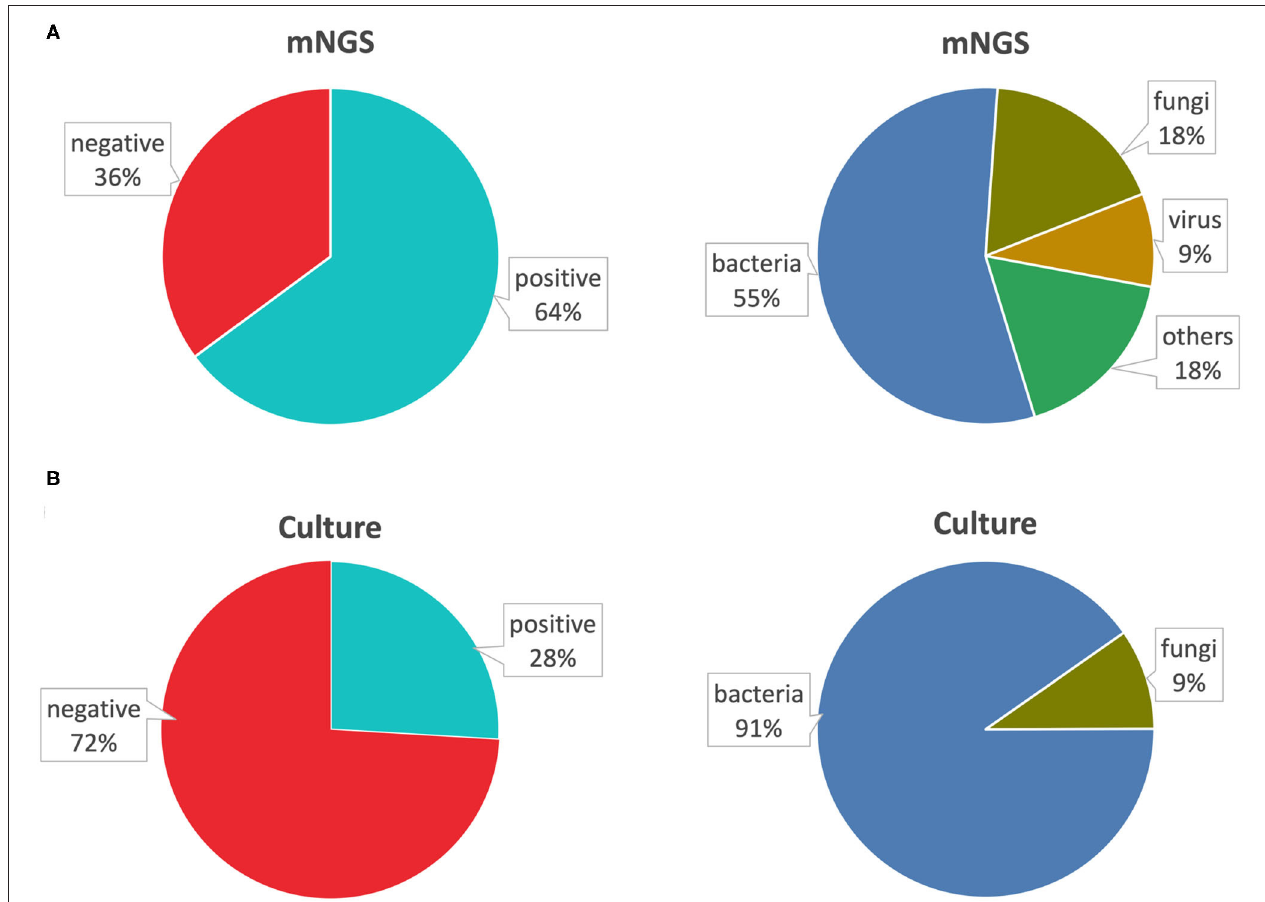
FIGURE 3 | Comparison of positive rate of pathogens by BALF mNGS and culture. (A) The positive rate of mNGS and the types of pathogens detected. (B) The positive rate of BALF culture and the types of pathogens detected. BALF, bronchoalveolar lavage fluid; mNGS, metagenomic next-generation